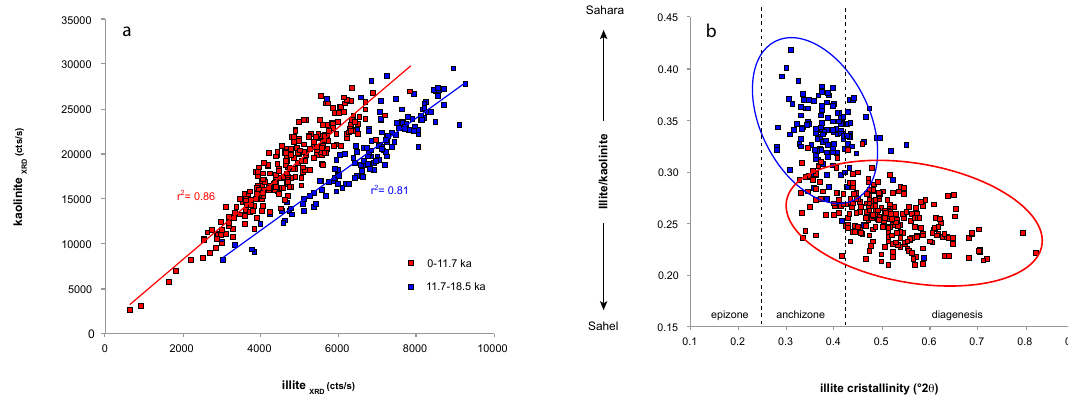
Fig. 6. Comparison of the mineralogical and geochemical signatures before and after 11.7kyr, (a) kaolinite versus illite (XRD counts/s) evidencing contrasting provenance between 18.5 and 11.7ka (red squares) and between 11.7ka and top of the core (blue squares); (b) illite Bout-Roumazeilles et al. Tracking atmospheric and riverine - Figure 6 to kaolinite ratio as a function of illite crystallinity (K¨ubler Index), diagenesis, epizone and anchizone limits.